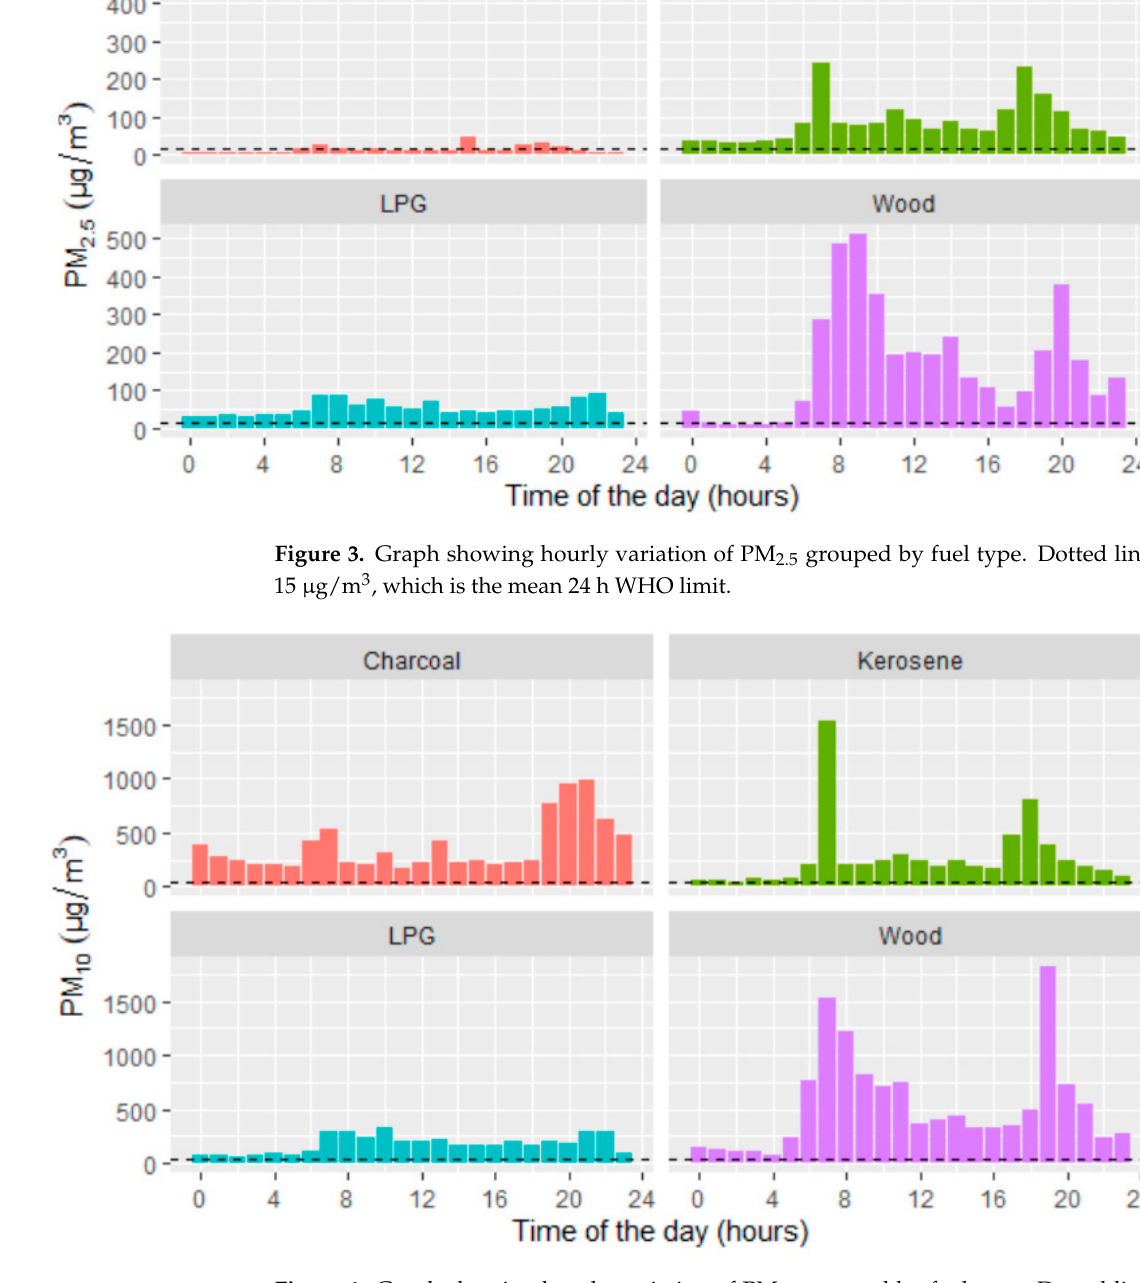
Figure 5. Graph showing daily variation of PM 2.5 by fuel type. Dotted line plotted at 15 µg/m 3 , which is the mean 24 h WHO limit.